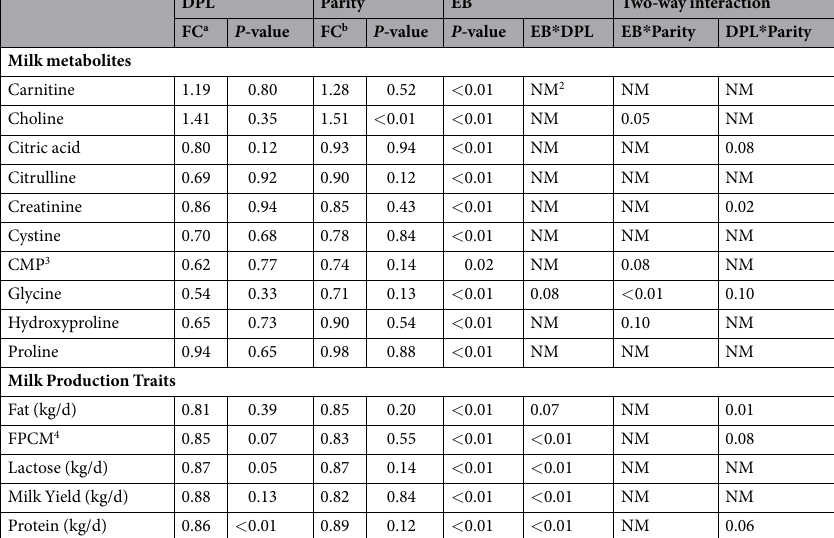
per day for 0-d vs. 30-d dry period in week 2, P -value = 6.7 × 10 − 3 ; and 112.7 vs. − 27.3 kJ/kg 0.75